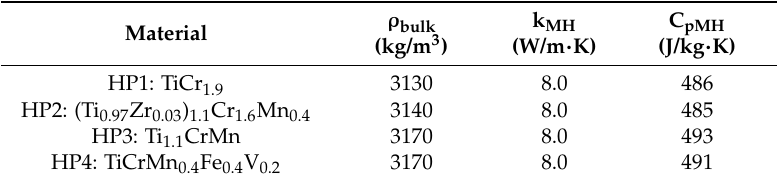
Table 2. Chemical and physical properties of the four downselected high-pressure metal hydrides (HP1, HP2, HP3, and HP4). The values of bulk density ( ρ bulk ), thermal conductivity ( k MH ) and specific heat ( C pMH ) are